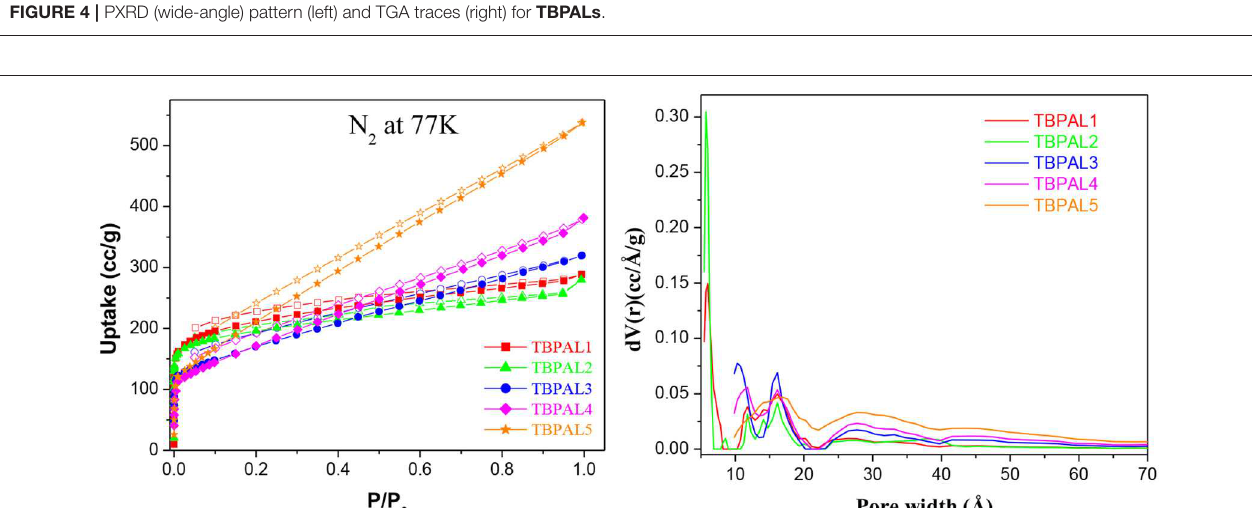
FIGURE 4 | PXRD (wide-angle) pattern (left) and TGA traces (right) for TBPALs .